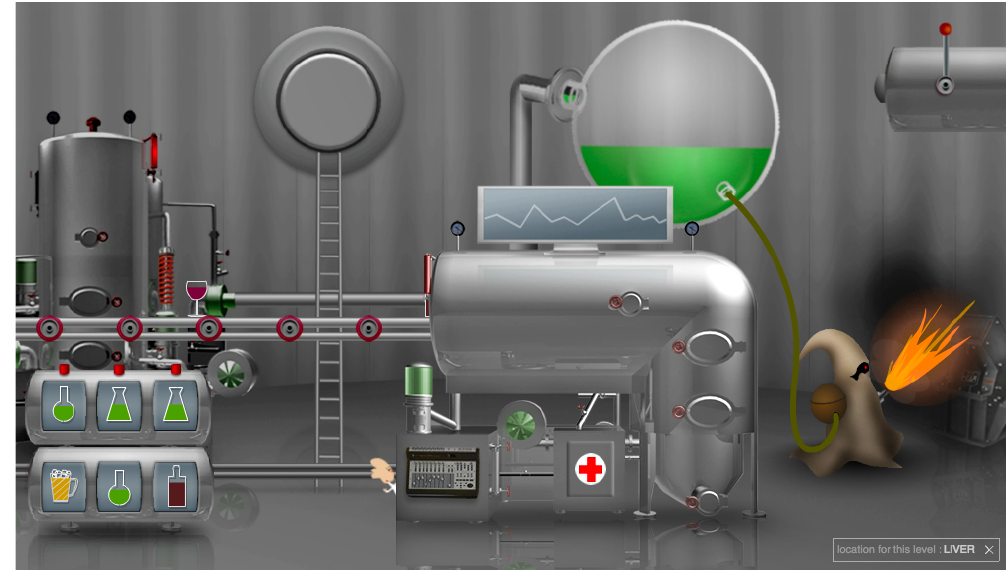
Figure 2. Screenshot of Veevia Cancer Game